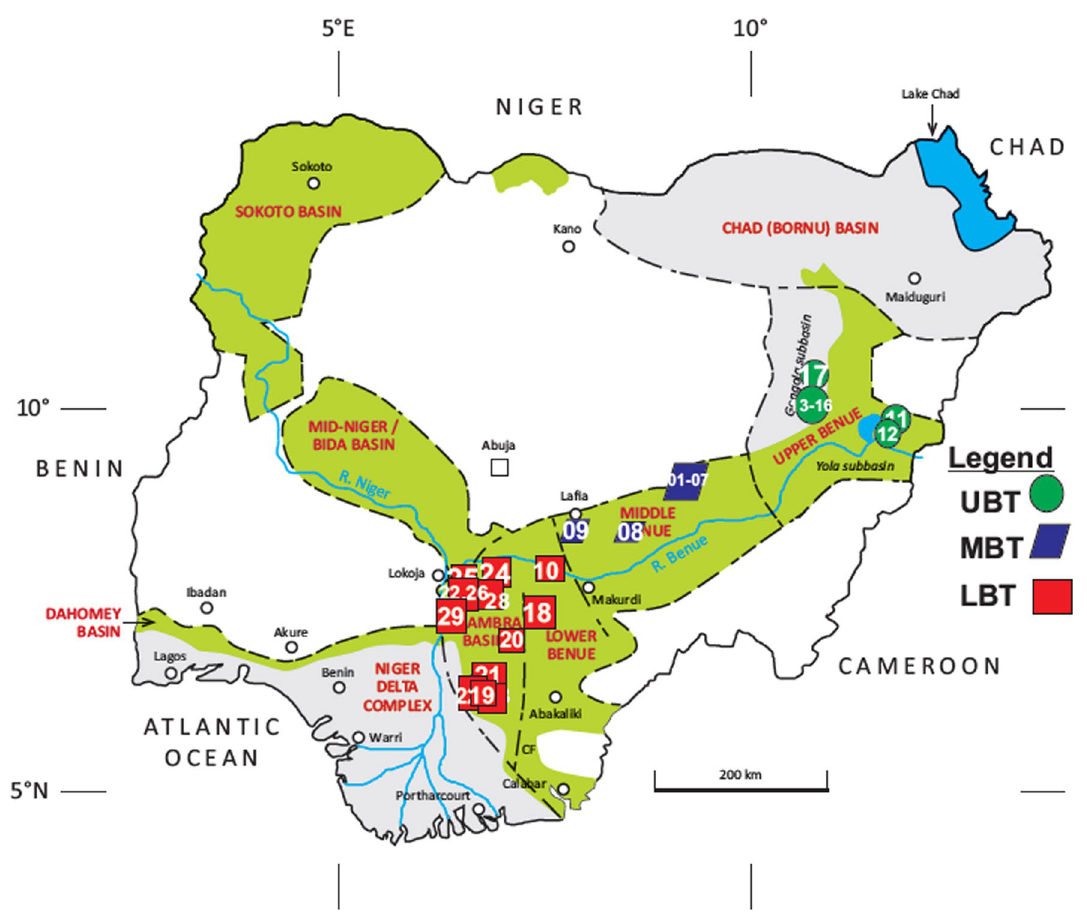
Fig. 2 Sample location map (modified after Obaje 2009). Refer to Table 2 for location details